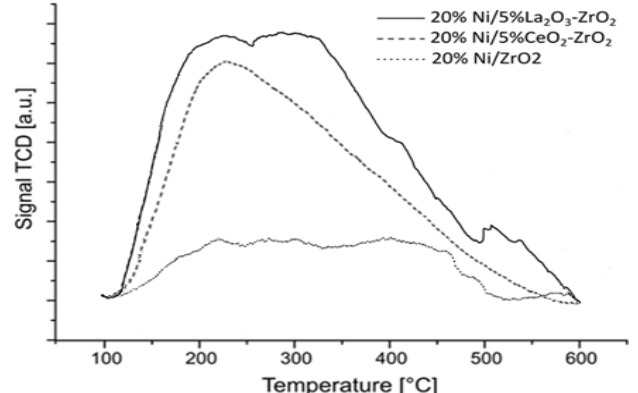
Figure 18. TPD-NH 3 profile of 20%Ni / ZrO 2 , 20%Ni / 5%CeO 2 -ZrO 2 , and 20%Ni / 5%La 2 O 3 -ZrO 2 catalysts reduced in hydrogen for 1h at 500 °C.